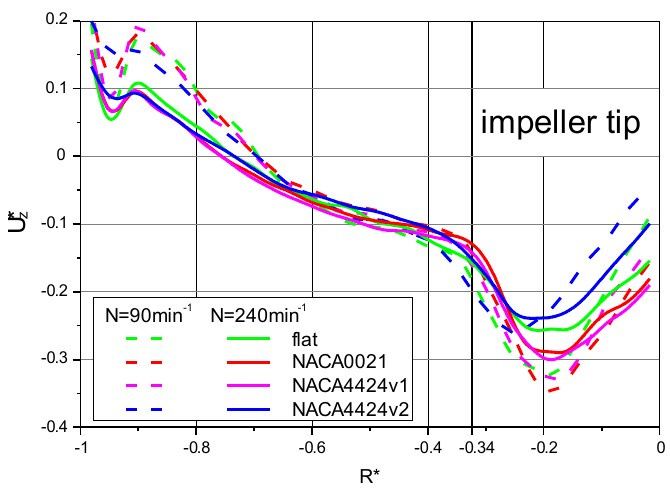
Figure 11. Profiles of axial dimensionless velocities at the height of the circulation core.